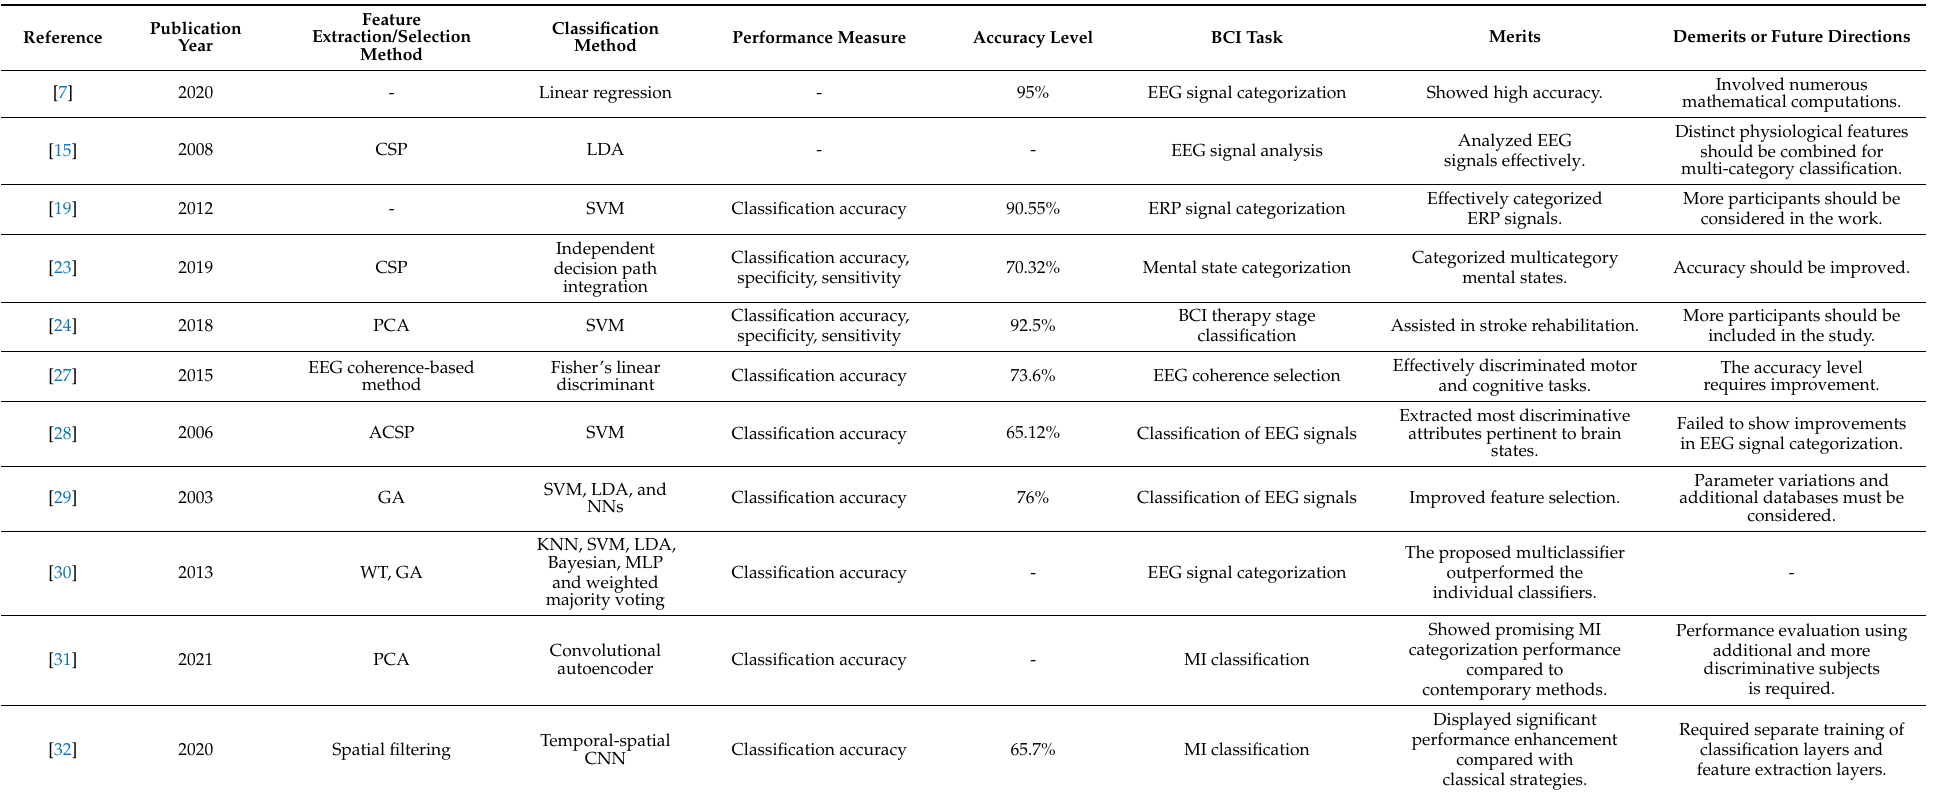
Table 1. Comparison of feature extraction and classification